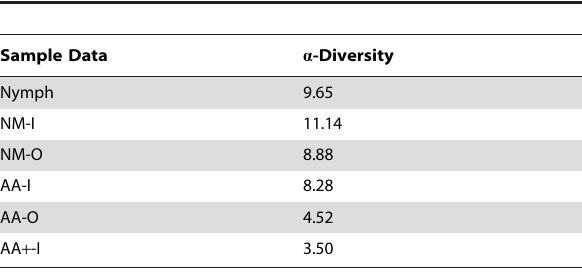
Table 3. Alpha diversity values for all groups at the species level calculated using MG-RAST analysis server.